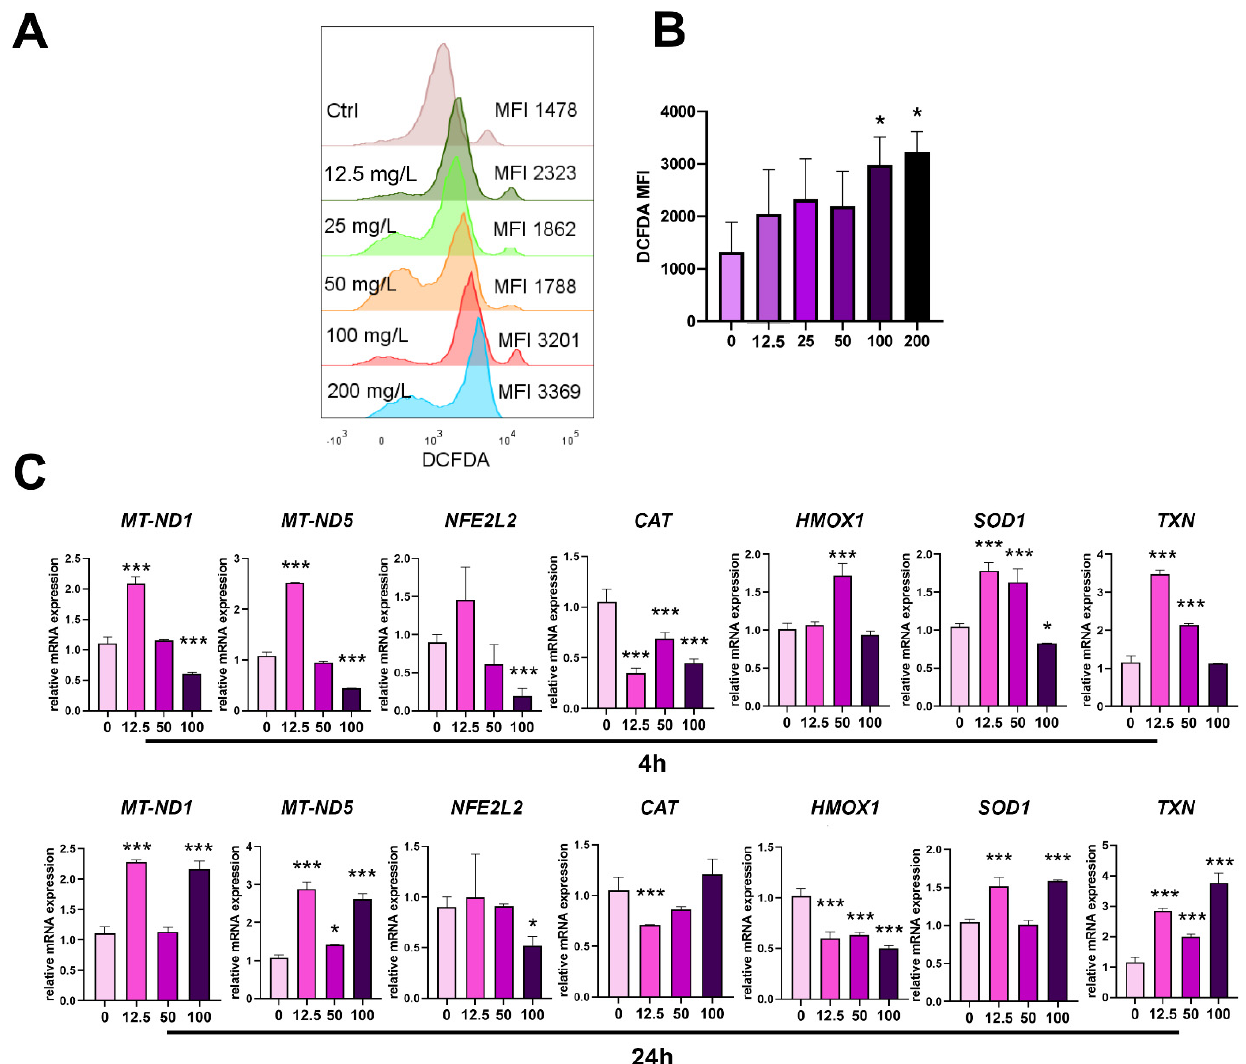
Figure 4. The effects of PoPEx on oxidative stress in PBMC. PBMC (3 × 10 5 /well) were cultured with PoPEx (6.25–200 µg/mL) for 24 h, followed by DCFDA staining and analysis by flow cytometry. ( A ) A representative analysis of DCFDA intensity is shown, along with the summarized data ( B ). ( C ) Relative mRNA expression for indicated genes in PBMC treated with 12.5 µg/mL, 50 µg/mL or 100 µg/mL for 4 h or 24 h, was determined by qPCR using the 2 −∆∆ Ct method and β -actin as a reference gene in the treated groups. The summarized data ( B , C ) are shown as mean ± SD from three inde- pendent experiments. * p < 0.05, *** p < 0.005, compared to control non-treated PBMC (Friedman test; Dunn’s multiple comparison post-test).